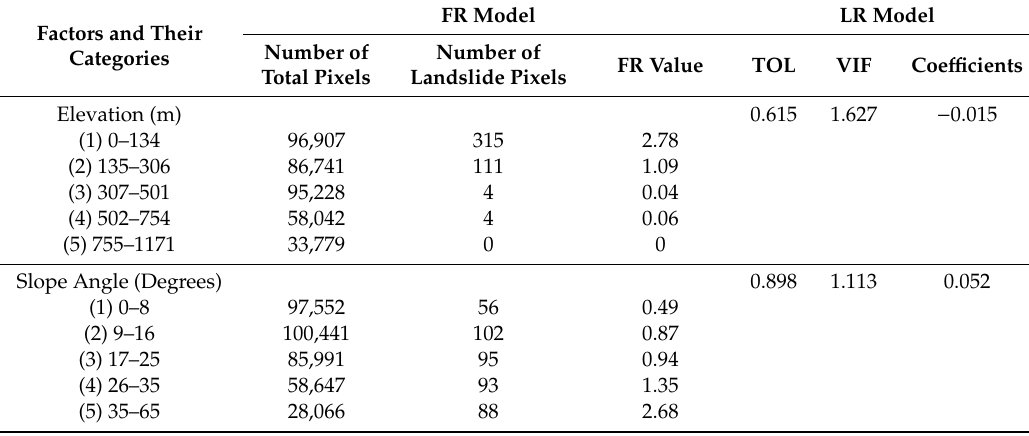
Table2. Valuesderivedfromthefrequencyratio(FR)modelforallfactorcategories, andmulticollinearity checking indexes (tolerance (TOL) and variance inflation factor (VIF)) and coe ffi cients derived from logistic regression (LR) model for all